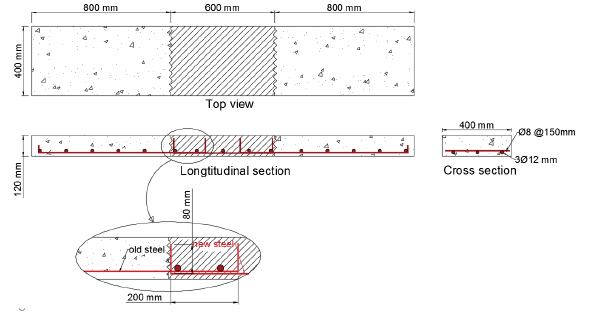
Figure 4: Dimensions and details of specimens